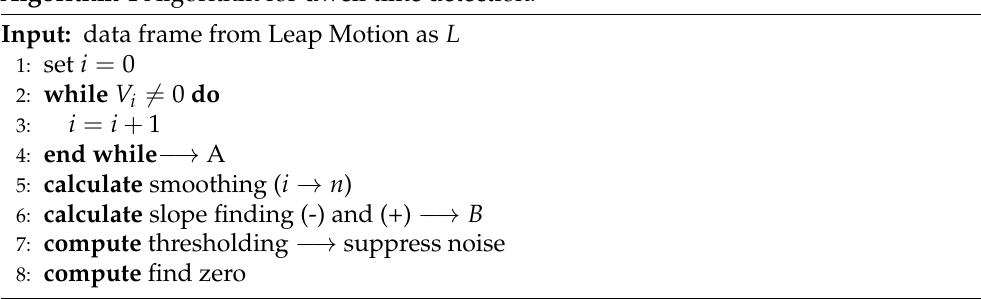
Algorithm 4 Algorithm for dwell time detection.